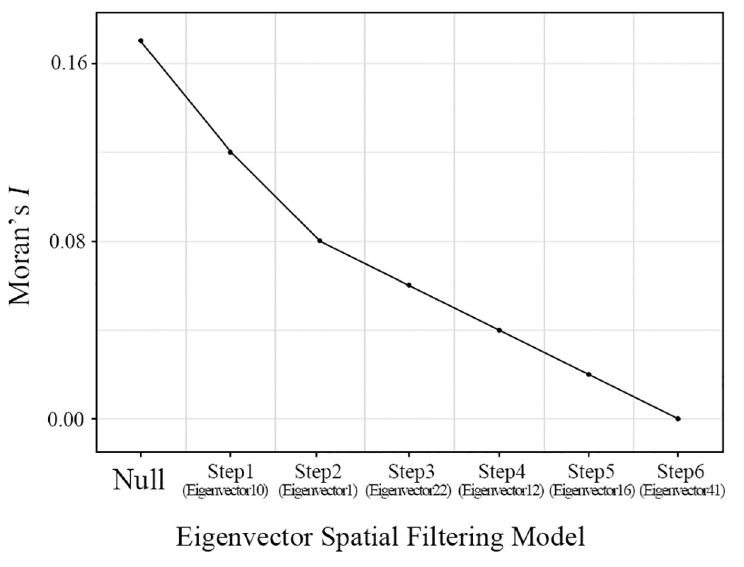
Fig 3. Spatial autocorrelation in ESFM